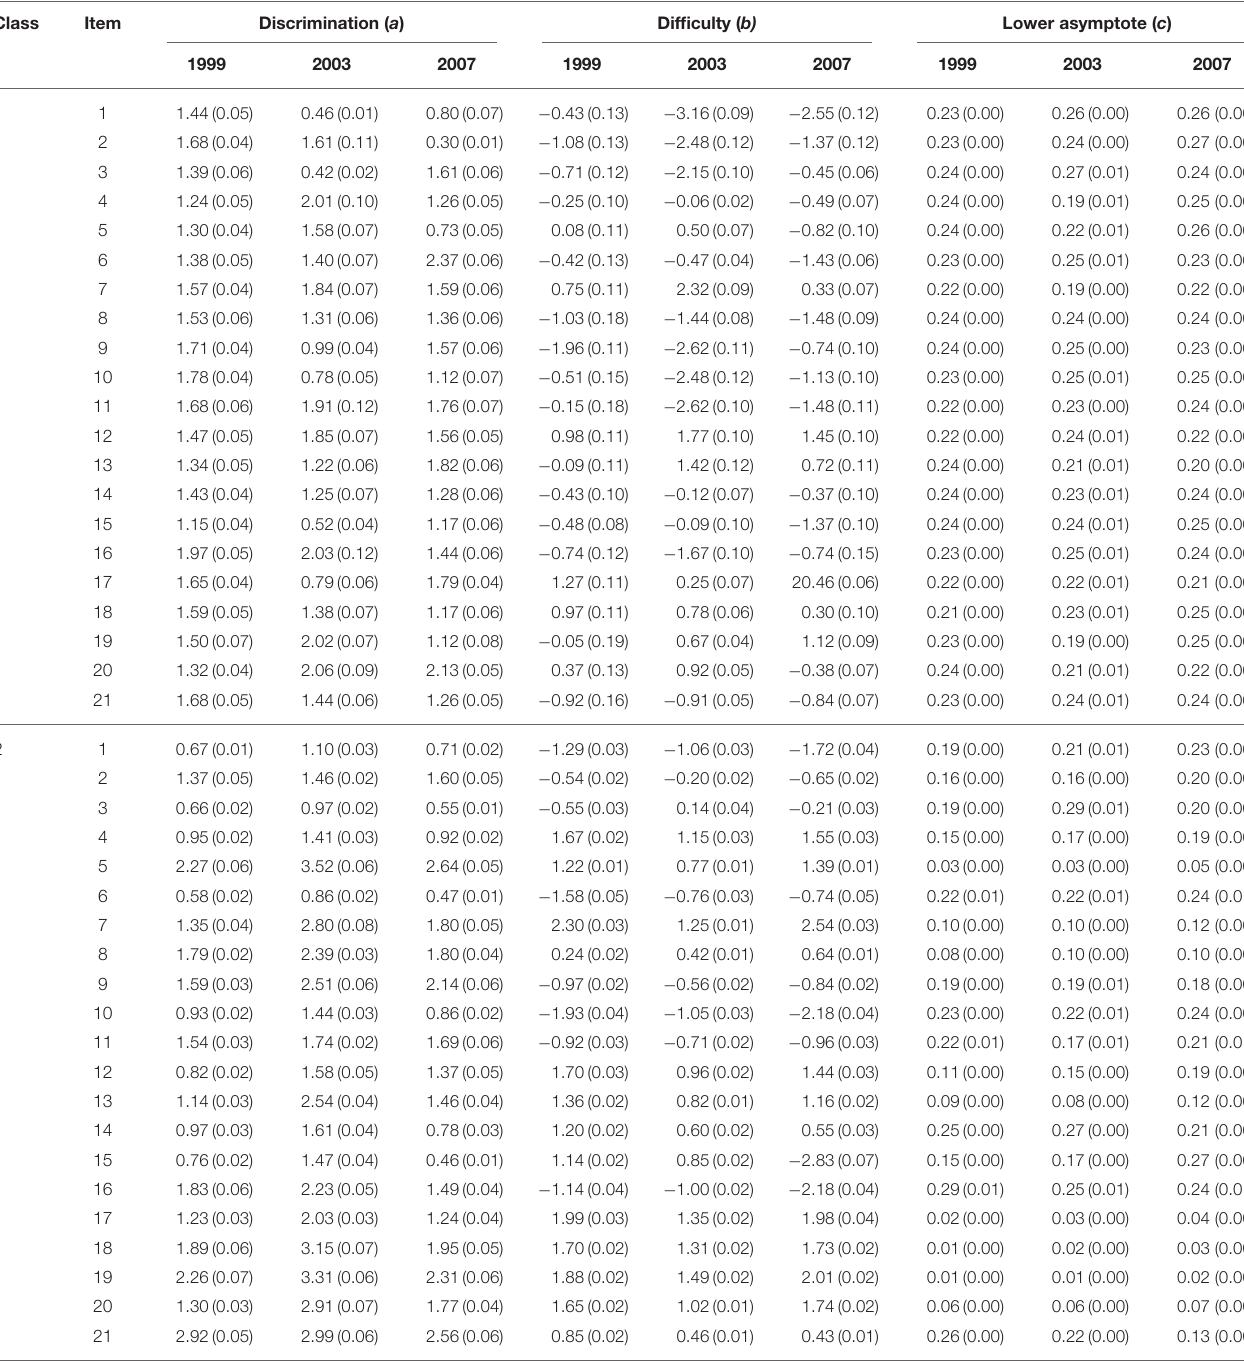
TABLE 2 | Item parameter estimates of the 21 trended anchor items in 1999, 2003, and 2007 TIMSS: Two-class mixture 3PL IRT model.